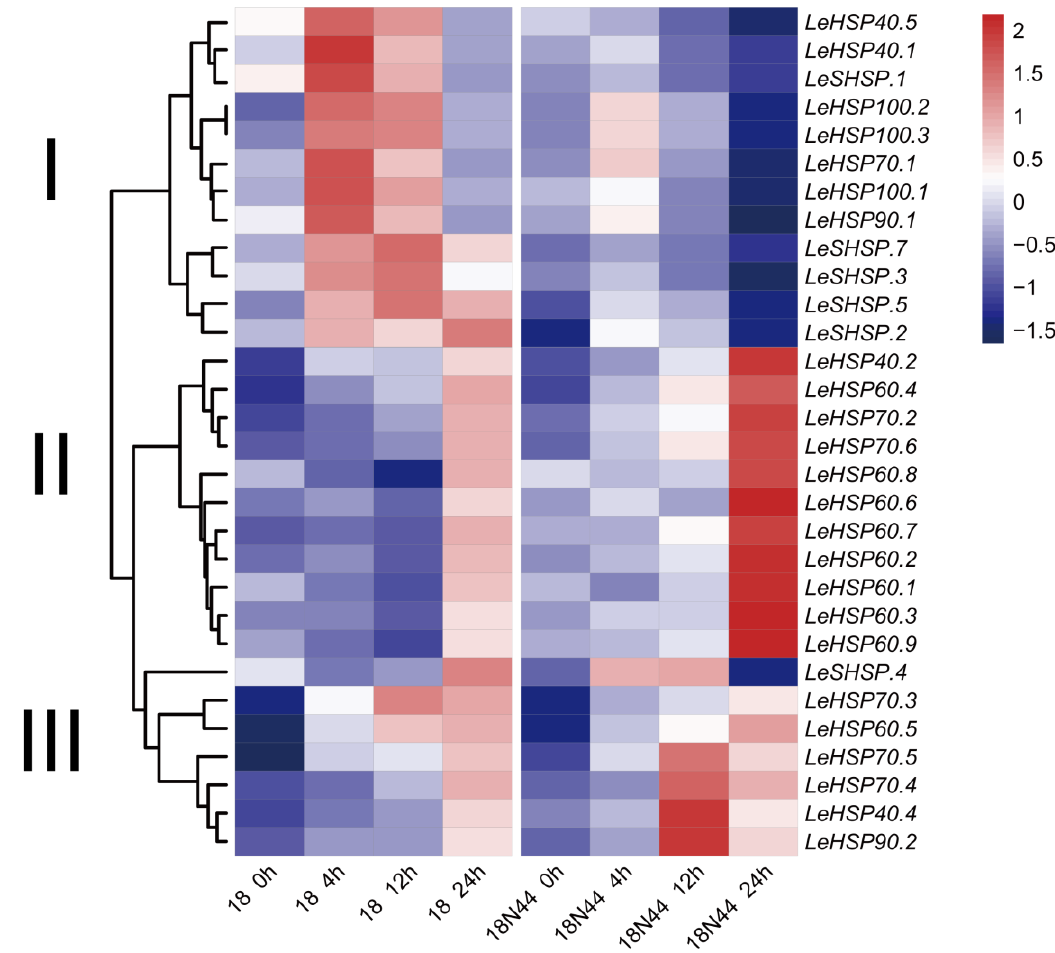
Figure 5. Heat map of the expression profiles of LeHSP genes in response to heat stress. The FPKM values of LeHSP genes were Z-scores normalized and centralized by a unit variance scaling method.